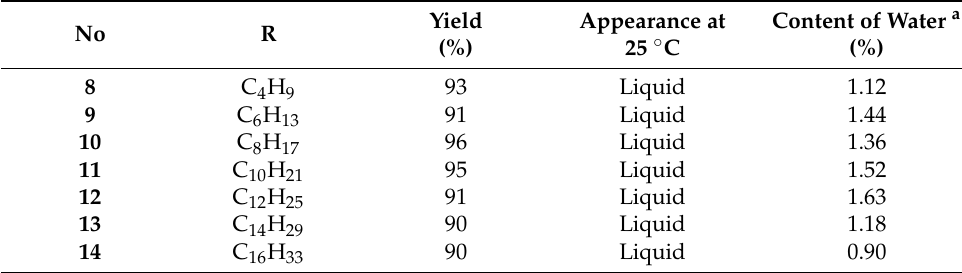
Table 2. Synthesized alkyldimethylglycinium 2-(2,4-dichlorophenoxy)propionates ( 8 – 14